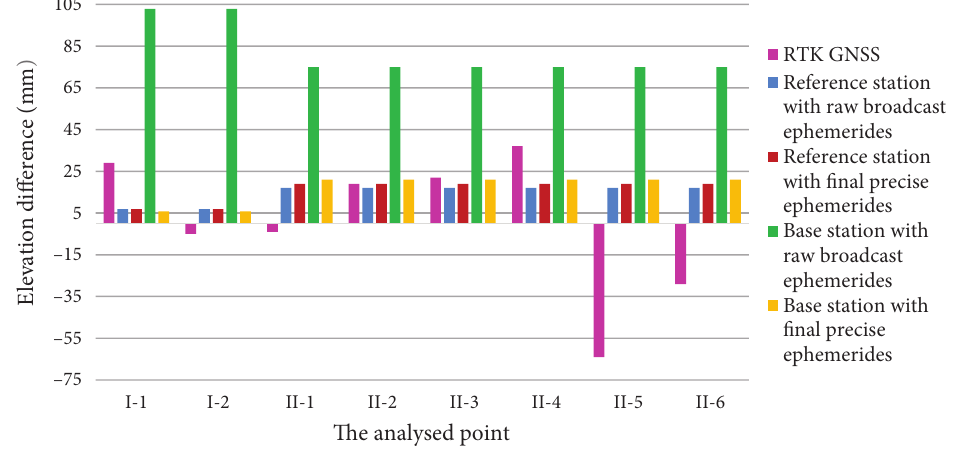
Figure 7. RTK GNSS and aligned MLS point cloud data calculated with four different schemes difference from levelled height (Annok,